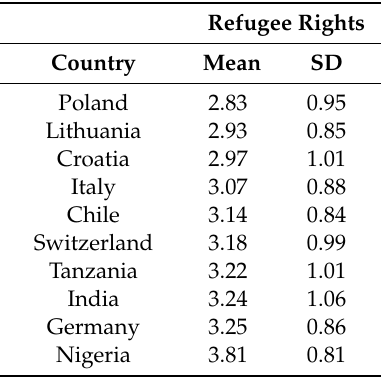
Table 3. Mean and standard deviation (SD) of attitudes towards refugee rights by